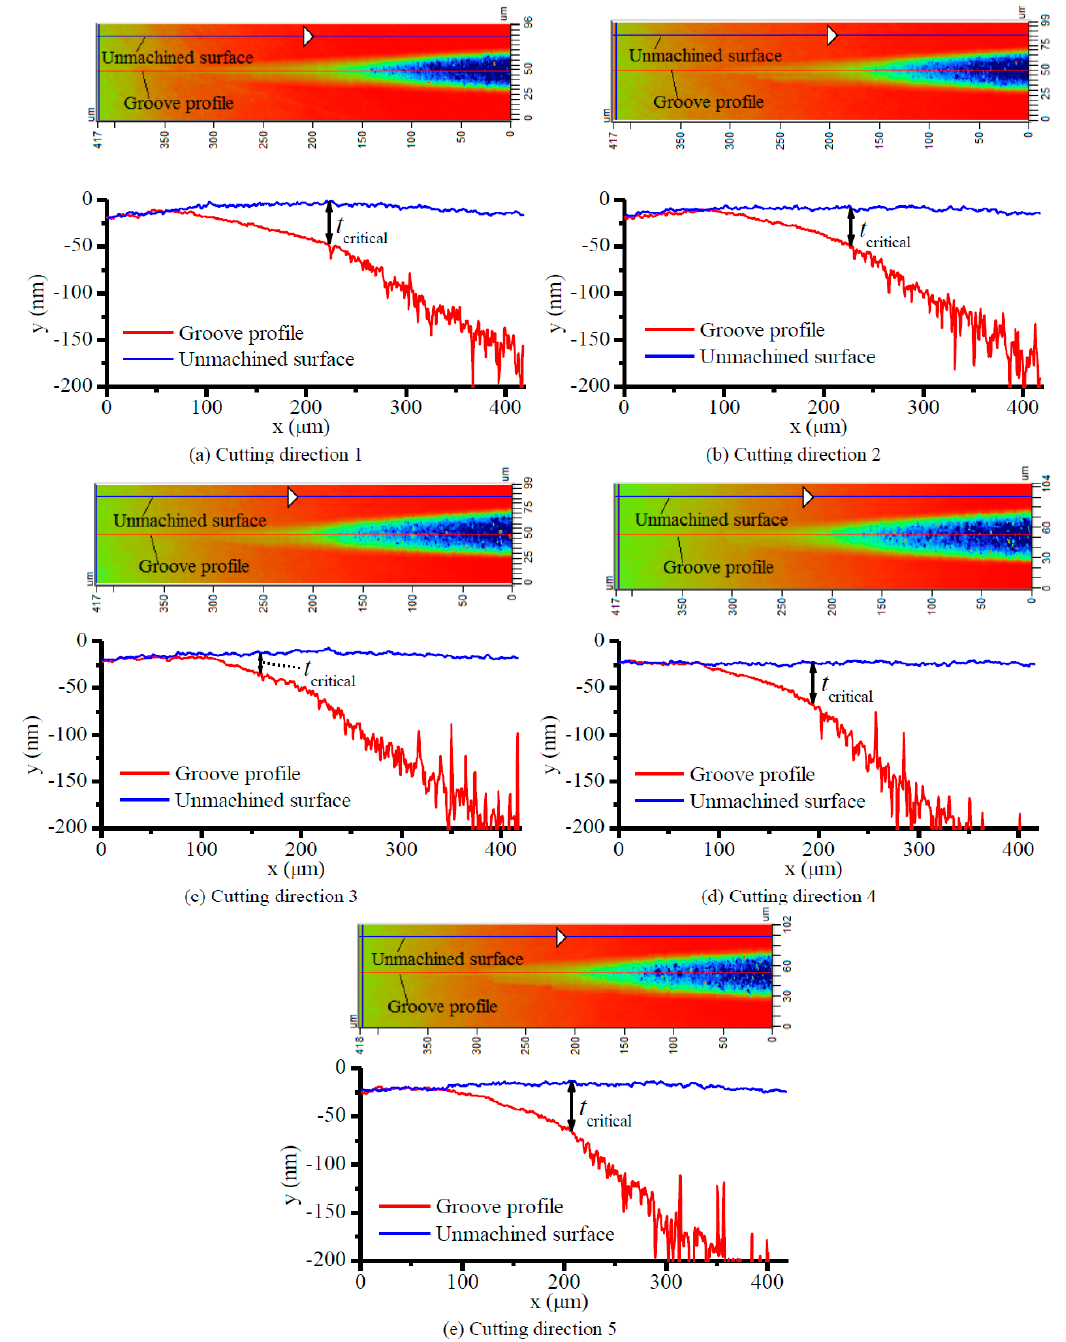
Figure 12. Profiles of the taper grooves.